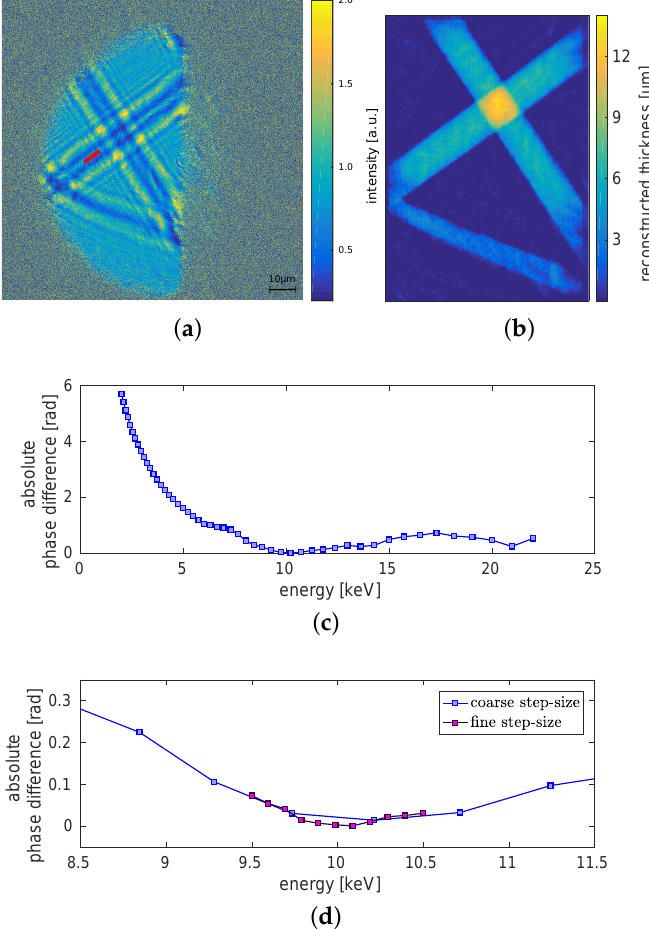
Figure 9. ( a ) Detector read-out of the propagation signatures of three carbon wires acquired at Diamond Light Source (DLS). ( b ) Reconstructed thickness of the carbon wires at the correct energy of 10keV. ( c , d ) Absolute difference between mean phase-shift of the region marked with the red line in ( a ) and theoretical value depending on the energy. ( c ) Whole energy range between 2keV and 22keV. ( d ) Energy range around the minimum between 9.5keV and 10.5keV in finer steps (purple). In blue the corresponding section of the plot in ( c ) is shown. The error is in the range of